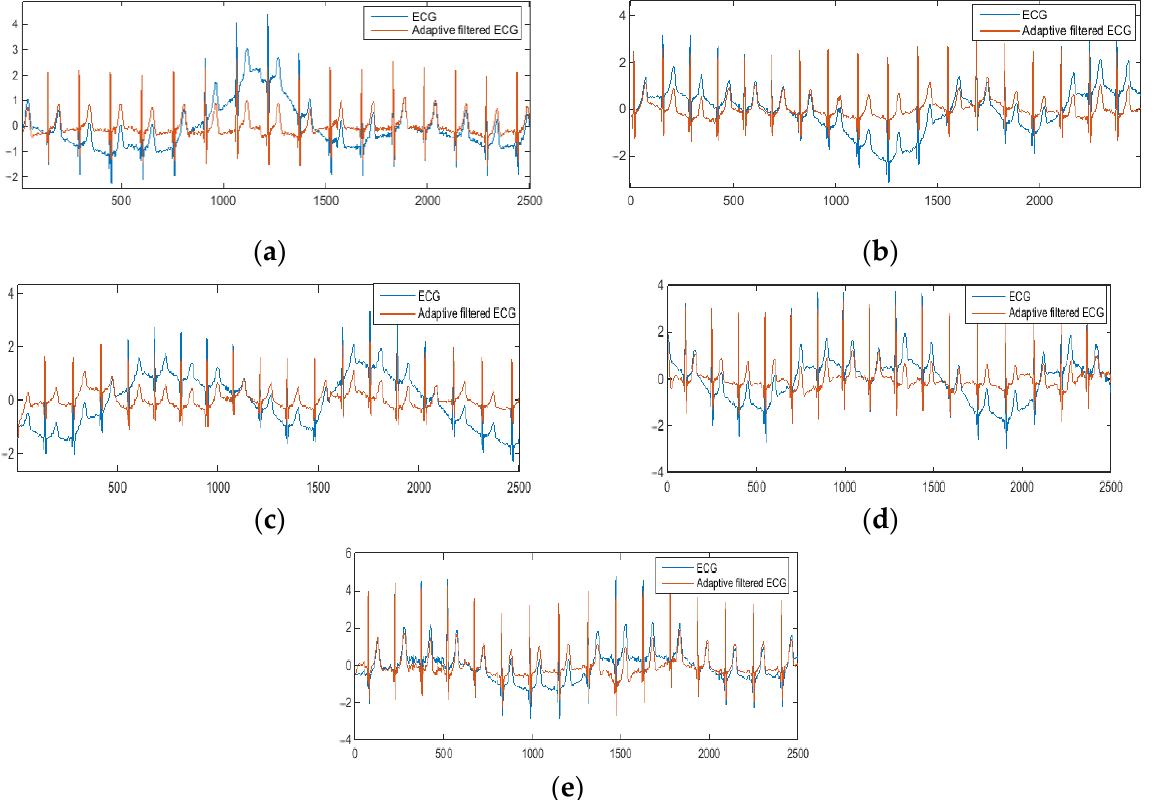
Figure 10. The denoised ECG signal: ( a ) motion type I, ( b ) motion type II, ( c ) motion type III, ( d ) motion type IV, ( e ) motion type V.